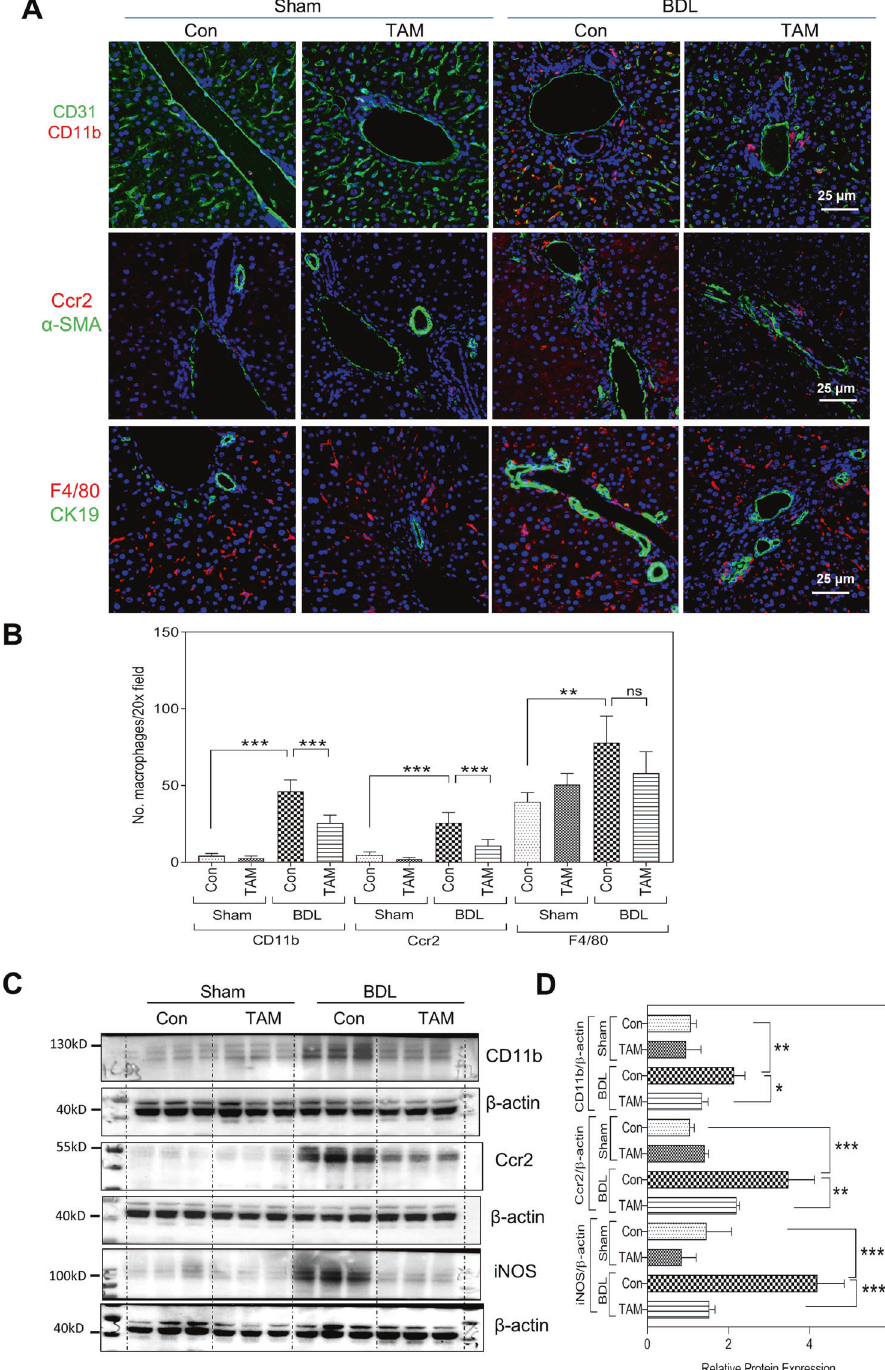
Fig. 7 H19 contributes to the activation and polarization of macrophages in the cholestatic livers. A Representative images of co-staining of CD31 and CD11b, α -SMA and Ccr2, F4/80 and CK19 in the liver sections from Sham, Sham + TAM, BDL, and BDL + TAM mice (each group, n = 3 – 6). Scale bars: 25 μ m. B Quanti fi cation of CD11b + , Ccr2 + , and F4/80 + cells of panel A . C Western blotting analysis for CD11b, iNOS, Ccr2, and β -actin in the liver tissues from Sham, Sham + TAM, BDL, and BDL + TAM mice. D Quanti fi cation of panel B . Data were expressed as mean ± SD. * P < 0.05; ** P < 0.01, *** P <